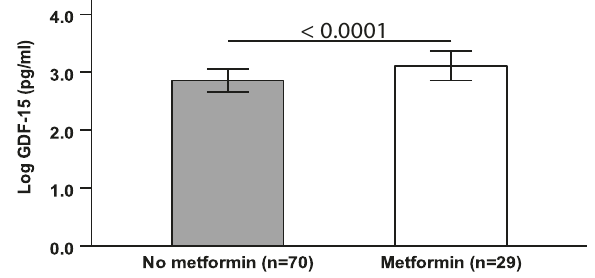
Fig. 3 Differences in serum GDF-15 concentrations in patients with NAFLD not receiving vs. receiving metformin treatment. Data are presented as means ± SD. Table 4. Multivariable linear regression models explaining variance in serum GDF-15 concentrations. Independent